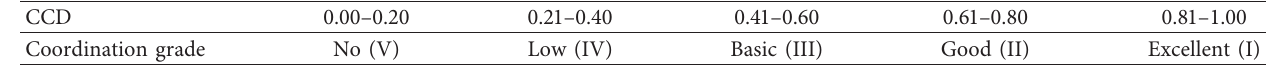
Table 3: Classification standard of coupling coordination degree.